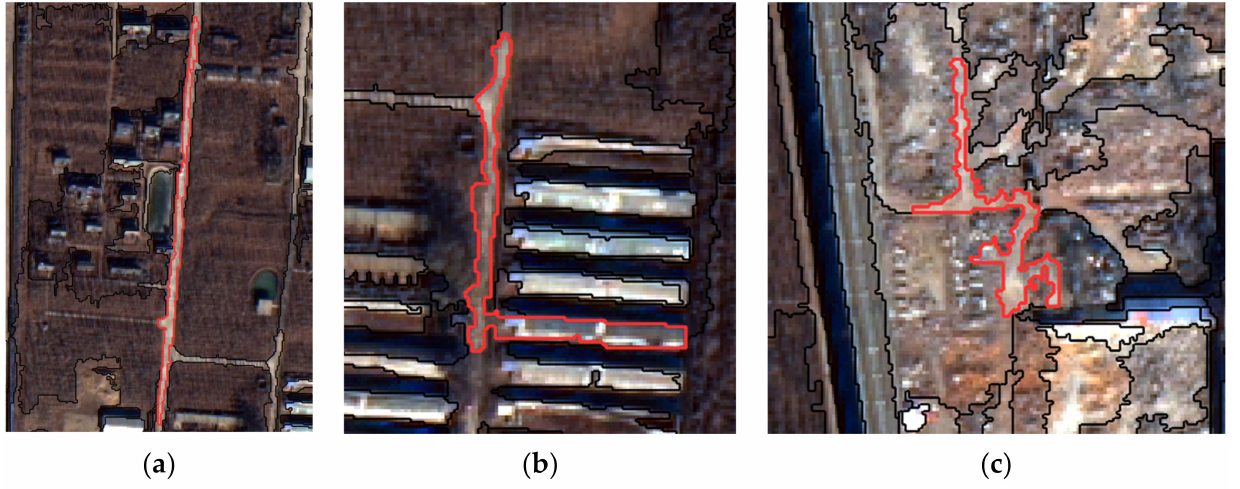
Figure 6. Geometric features of roads: ( a ) Linear image objects, ( b , c ) image objects with low